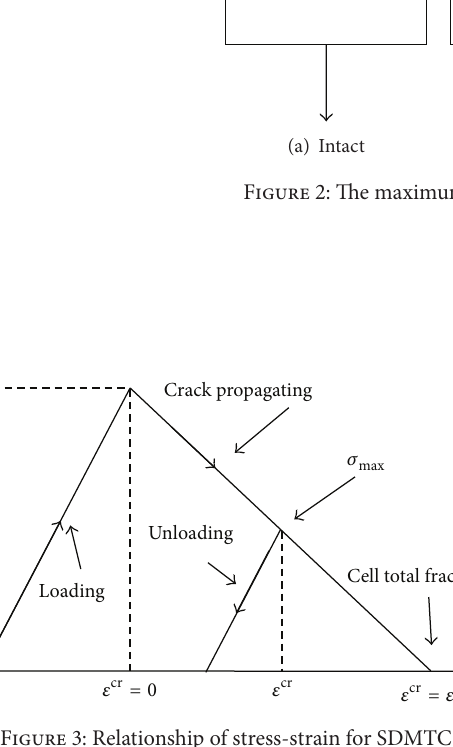
Figure 3: Relationship of stress-strain for